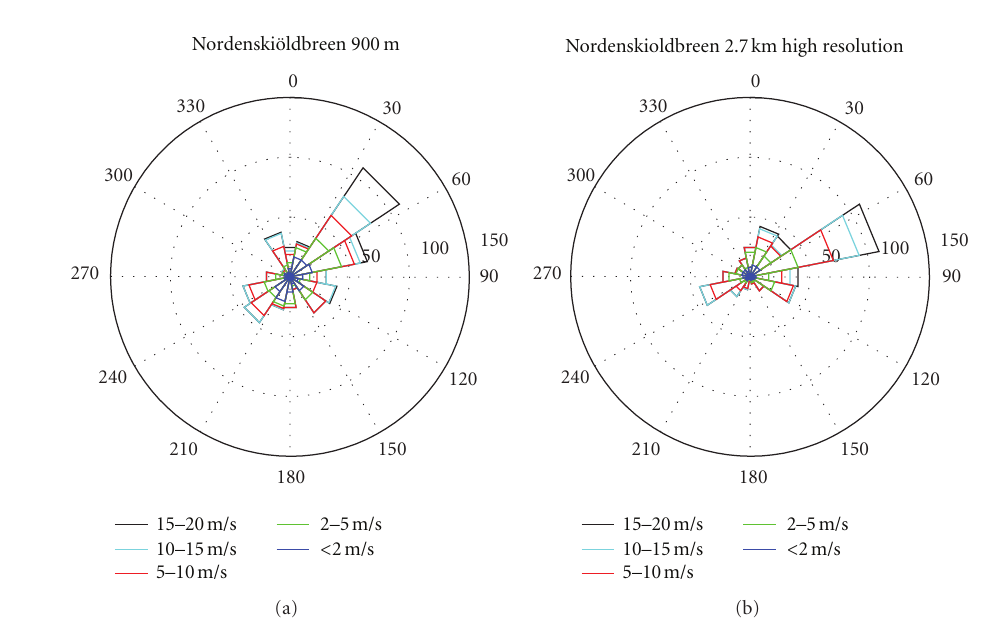
Figure 11: Wind roses of simulated wind at Nordenski¨oldbreen in July together with January. Note that given frequency is absolute (hours).